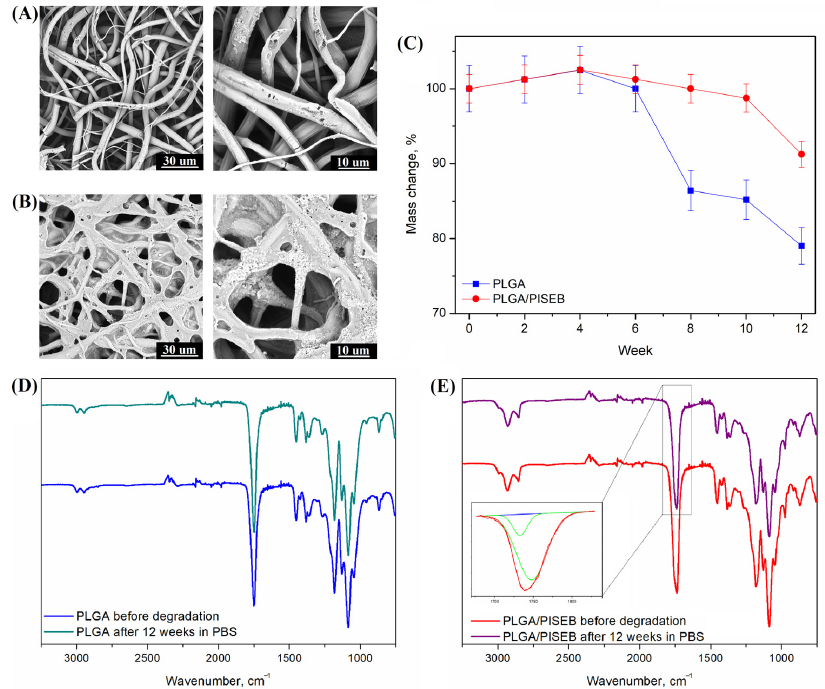
Figure 5. SEM micrographs of electrospun PLGA ( A ) and PLGA/PISEB ( B ) scaffolds, as well as percentage mass changes ( C ) after 12 weeks of hydrolytic degradation. IR spectra of electrospun PLGA ( D ) and PLGA/PISEB scaffolds ( E ) before degradation and after 12 weeks of hydrolytic degradation in PBS. Inset: deconvolution of a band representing stretching of ester –C=O groups typical for PLGA (1748 cm − 1 ) and PISEB (1733 cm − 1 ).